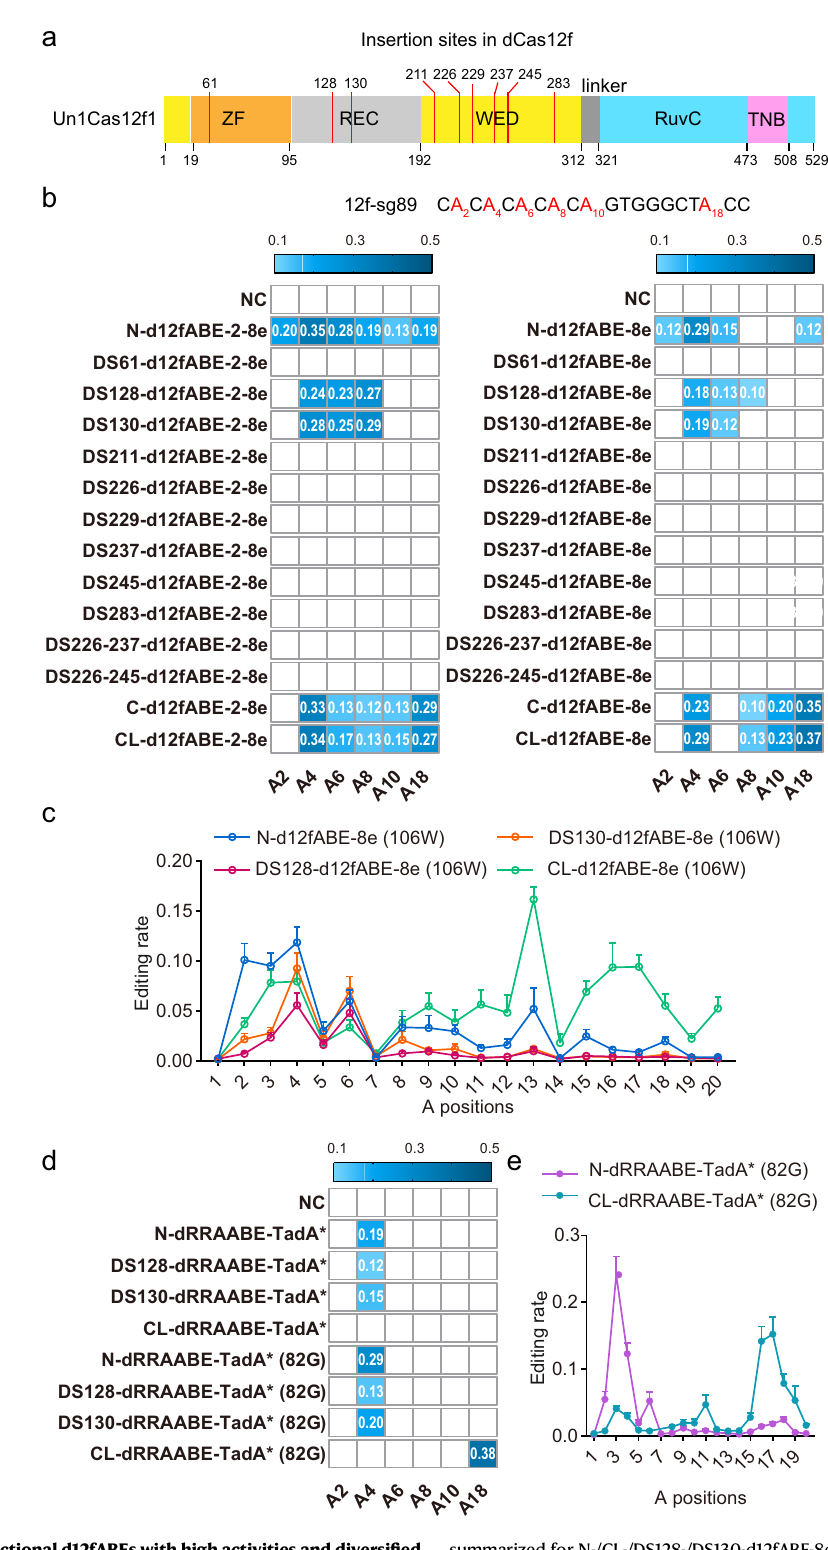
summarized for N-/CL-/DS128-/DS130-d12fABE-8e (106W) in blue, orange, violet, and green lines, respectively. d Heatmap showing editing activities of d12fABEs- TadA* and d12fABEs-TadA* (V82G) against sgRNA 12f-sg89 in blue gradient color. e A-to-G editing frequencies at each adenine position across 12 endogenous sites were quanti fi ed and summarized for N-dRRAABE-TadA* (82G) and CL-dRRAABE- TadA* (82G) in purple and cyan lines, respectively. NC negative control. All data werecollectedfromthreeindependentexperimentsandpresentedasmean±SEM. in histograms. Source data are provided as a Source Data fi